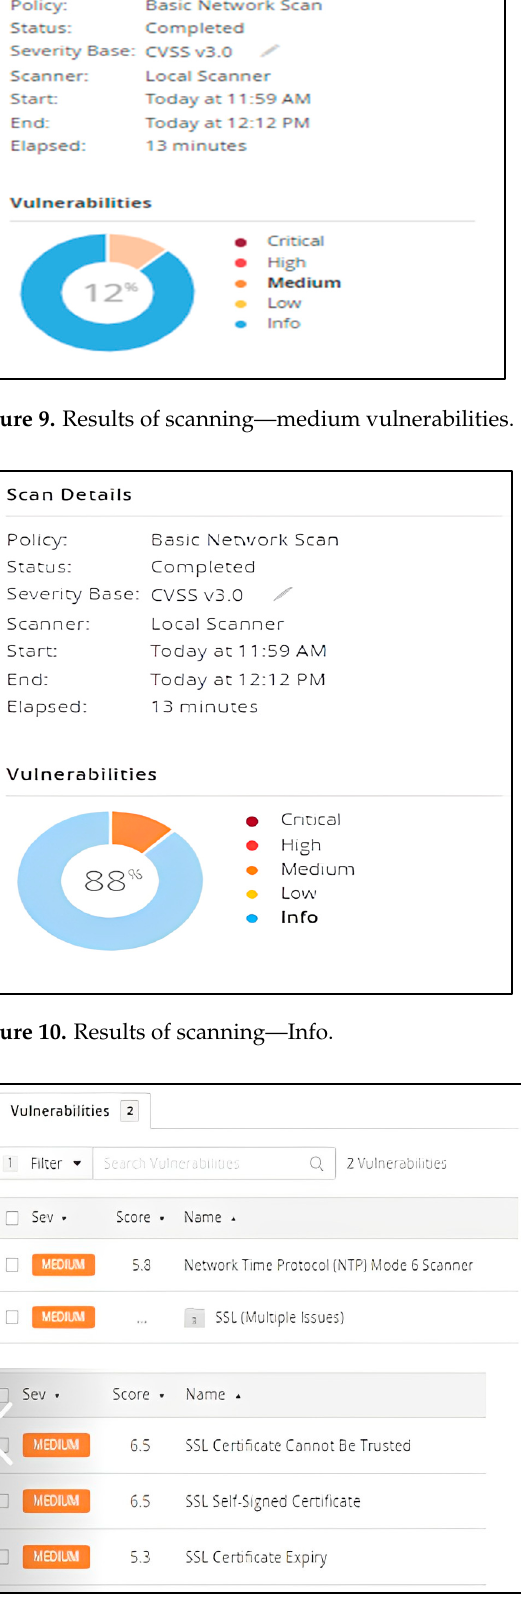
Figure 11. Medium Vulnerabilities detected.